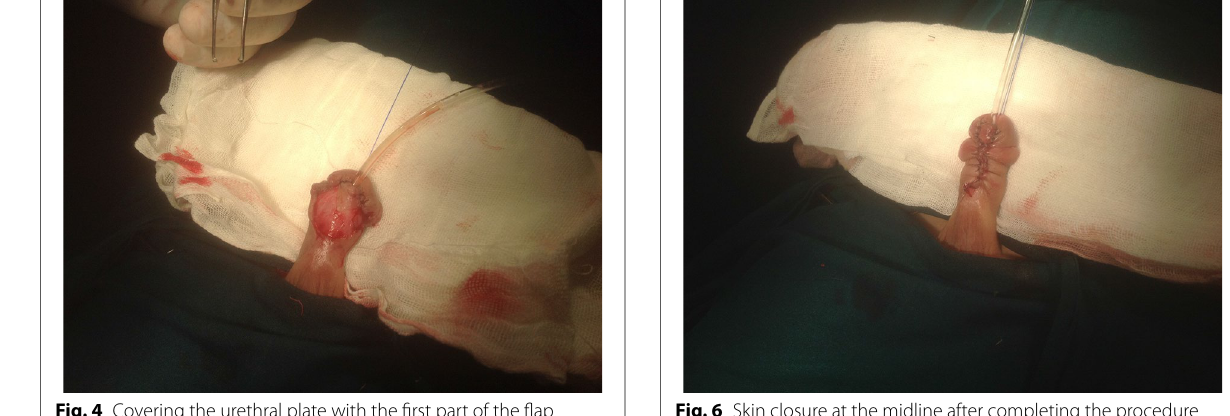
Fig. 6 Skin closure at the midline after completing the procedure